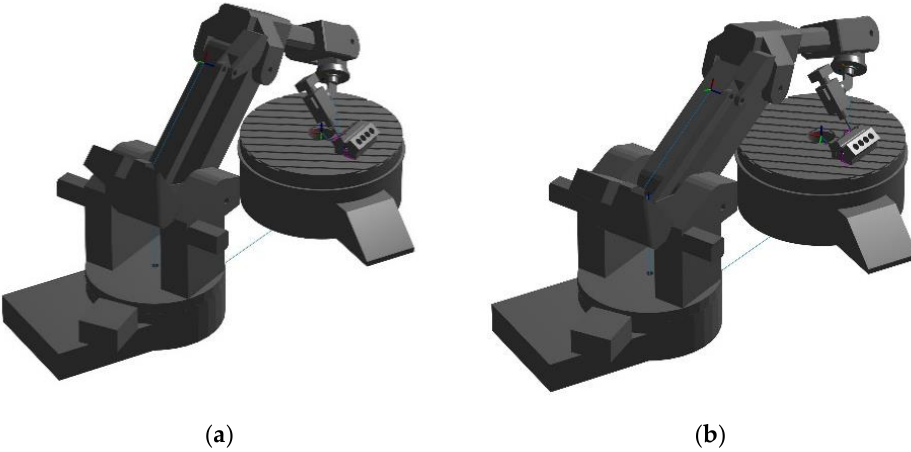
Figure 10. Optimized deburring of ( a ) cylinder bore 1 and ( b ) cylinder bore 4.